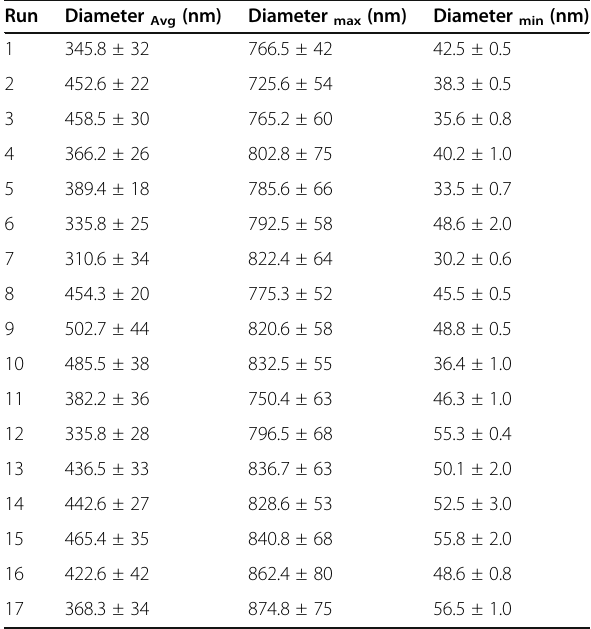
Table 5 Inulin powder average equivalent diameter and maximal and minimal diameters obtained at different Runs Run Diameter Avg (nm) Diameter max